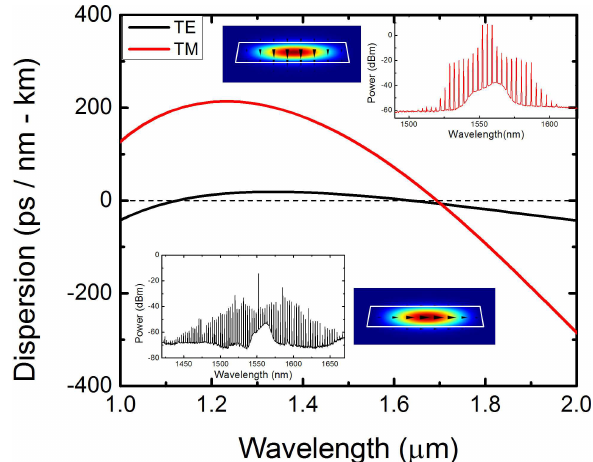
Figure 6: Simulated dispersion curve of the 650 nm by 3.5 µ m waveguide for TE (black) and TM (red) modes. The TE mode dis- persion at 1550 nm wavelength is smaller than that of the TM